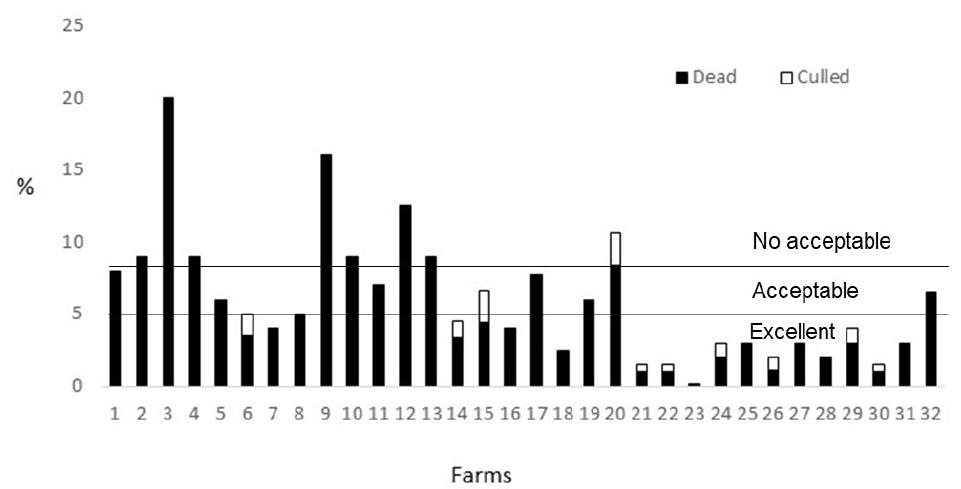
Figure 2. Mortality rates (in white: culled animals; in black: dead animals or overall mortality rates when % of culled animals were not given by the farmer) in growing-rabbit farms (n = 32) in relation to the classification of the animal welfare protocol, where up to 5% of mortality in at least the last thee months is considered excellent, up to 8% of mortality is considered acceptable, and any other value as not acceptable.